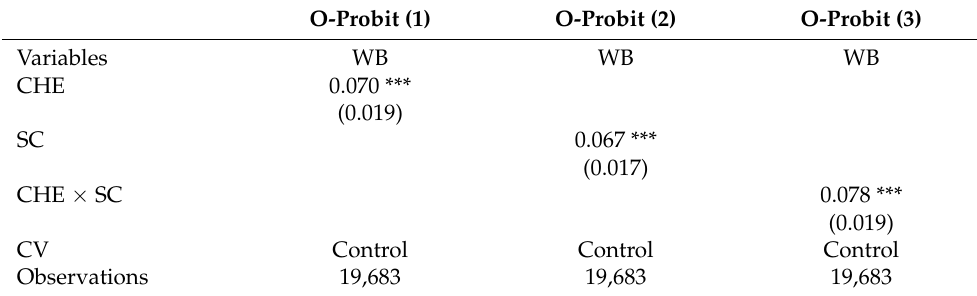
Table 8. The results of the moderation effect test for CHE and WB: